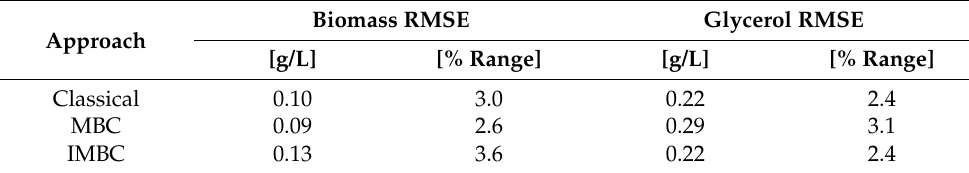
Table 3. Validation of simulated values with offline measurements. The simulated glycerol and biomass were used to train the chemometric model and to perform the principal compo- nents regression (PCR); these were different for the approaches due to the variation in optimized process